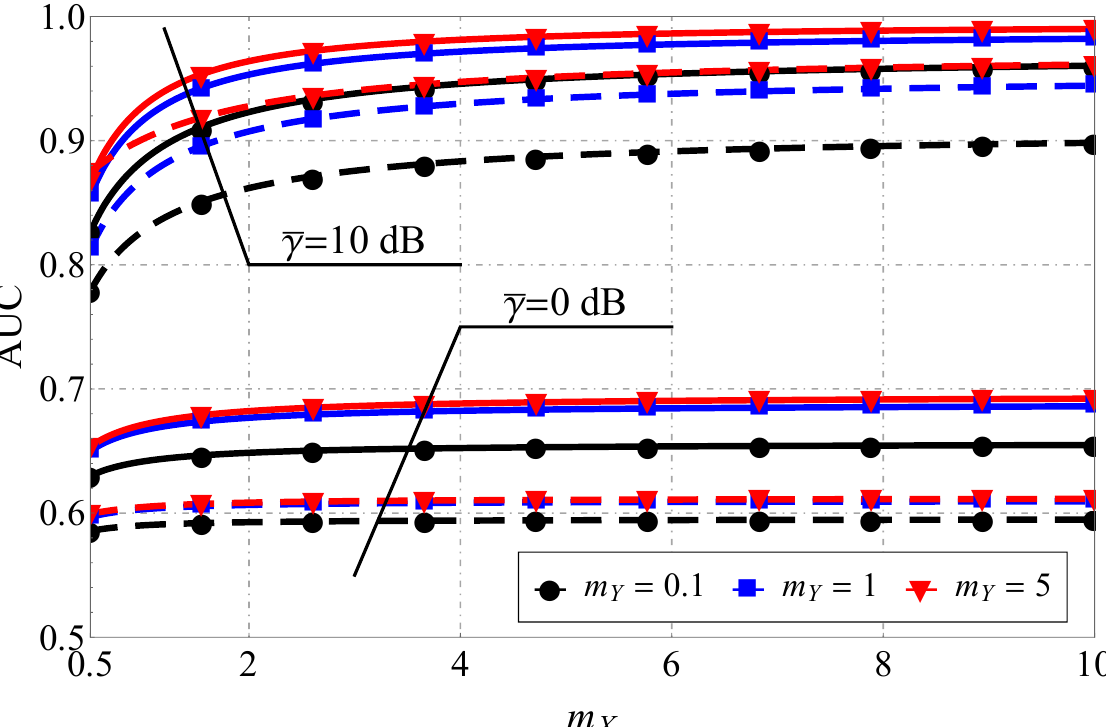
Figure 6. Average AUC comparison for the Beaulieu-Xie shadowed model for various m X and ¯ γ = 10 dB, Ω X = 1 dB, Ω Y = 1 dB: solid lines show u = 1, dashed lines show u = 5. It was found that the combination of various average powers of LoS/NLoS compo- nents (i.e., Ω Y and Ω X ) can lead to strictly antipodal behavior of the detection metrics. The research demonstrated that for heavy fading and shadowing conditions (both LoS and NLoS components) (see contour map in Figure 7), the increase in the total power of multipath waves (for a fixed power of dominant components) increases AUC, whereas, in the case of light fading with multiple LoS components (see contour map in Figure 8), the effects are exactly the opposite. Moreover, the lines of constant AUC (contour lines) can be approximated as Ω Y = Ω X + b dB , where b dB is a constant shift in a log scale, representing LoS/NLoS component power